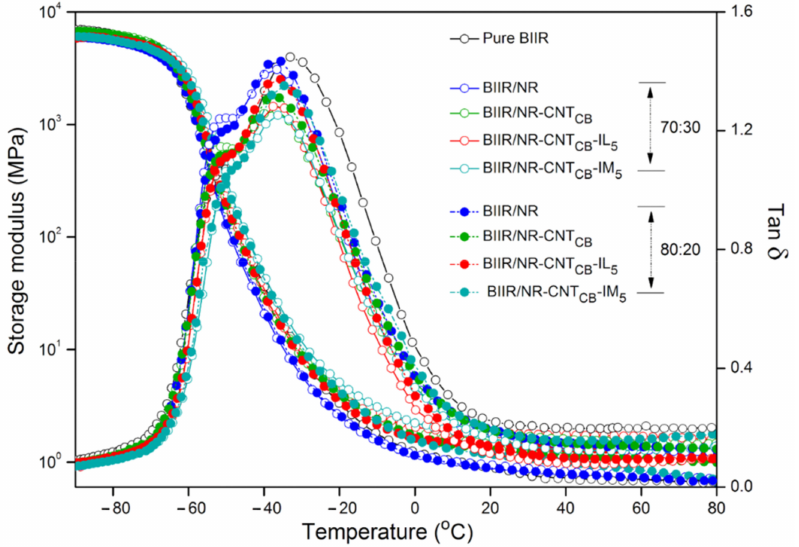
Figure 16. Storage modulus and Tan δ as a function of temperature of pure rubbers and their composites with and without IL and IM modifiers, BIIR:NR ratios of 70:30 and 80:20 after Taber abrasion